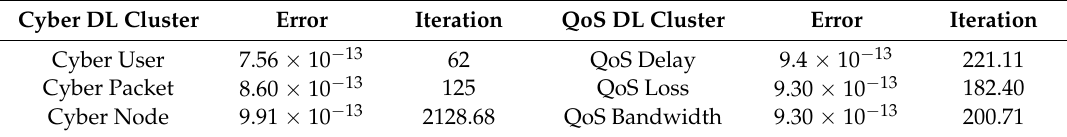
Table 16. Deep Learning Cluster Validation (5 × 5